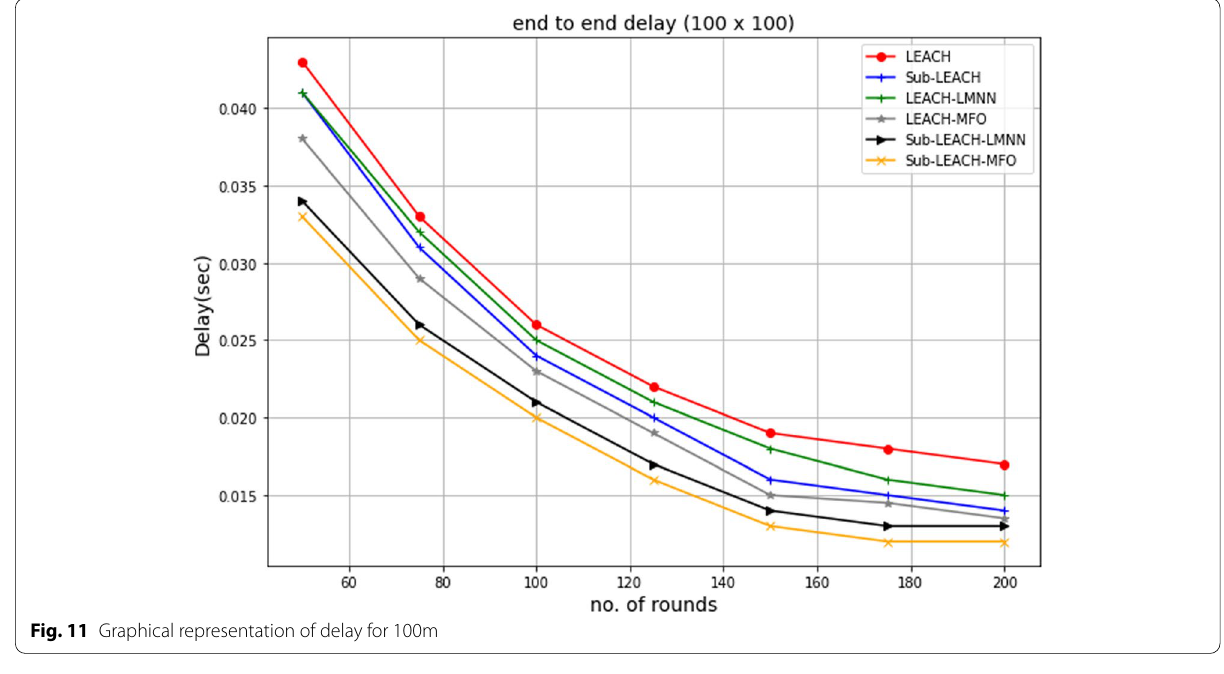
Fig. 11 Graphical representation of delay for 100m